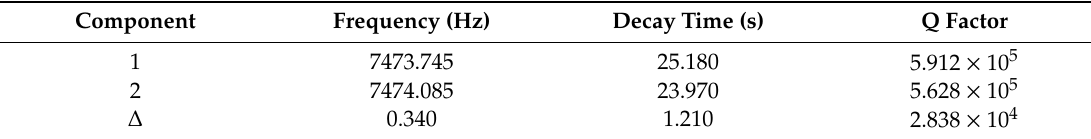
Table 3. The VCPs detected by electrostatic excitation and detection.